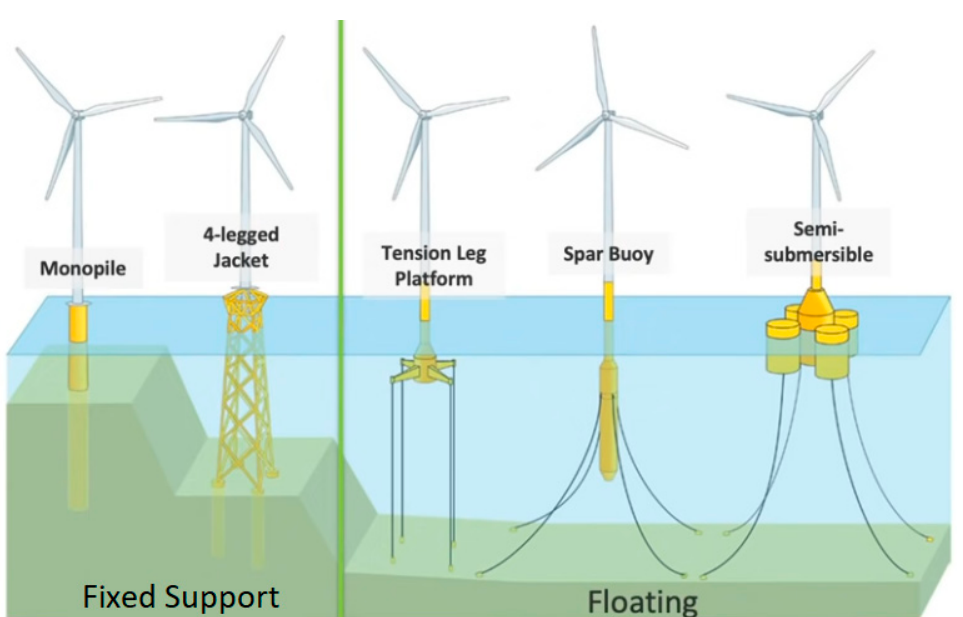
Figure 2. Support structures for offshore wind turbines (Adapted with permission from ref. [1].